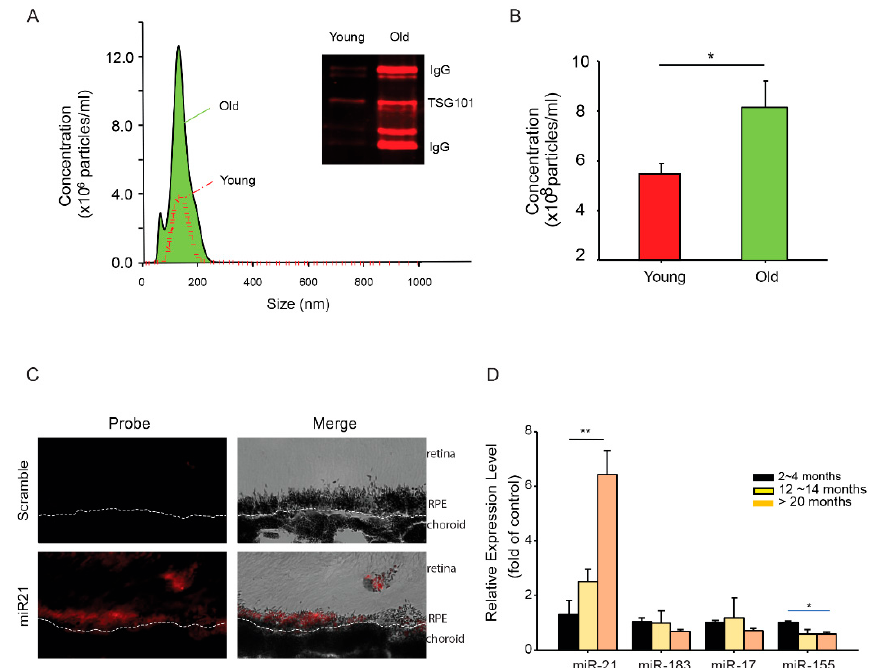
Figure 2. Age-dependent changes in RPE exosomes and miRNAs. ( A ) The size distribution of EVs in culture medium conditioned by young or aged mouse RPE / choroid tissue. Insert: Western blot of exosome marker proteins in isolated EVs. ( B ) Concentration of EV particles in mouse RPE / choroid-conditioned medium, as measured by nanoparticle tracking analyses. ( C ) In situ hybridization of miRNA-21. Panels of fluorescent and bright-field images were presented to show the expression of miR-21 in the RPE. Dashed line indicates the basal side of the RPE. ( D ) Quantitative RT-PCR analyses of selected miRNAs in RPE from mice at di ff erent age groups. Data presented are averages of 4 independent experiments (mean ± sem; * p < 0.05; ** p < 0.01).